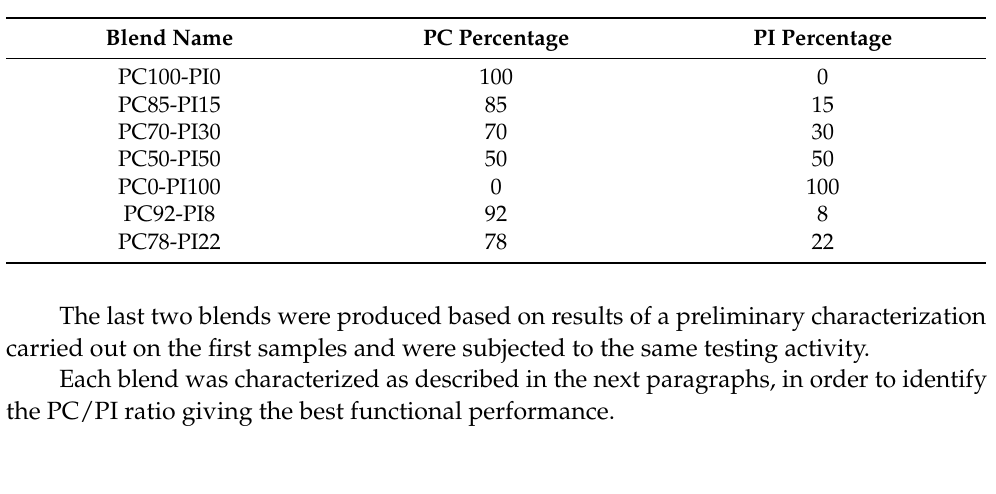
Table 2. Produced blends of post-consumer and post-industrial